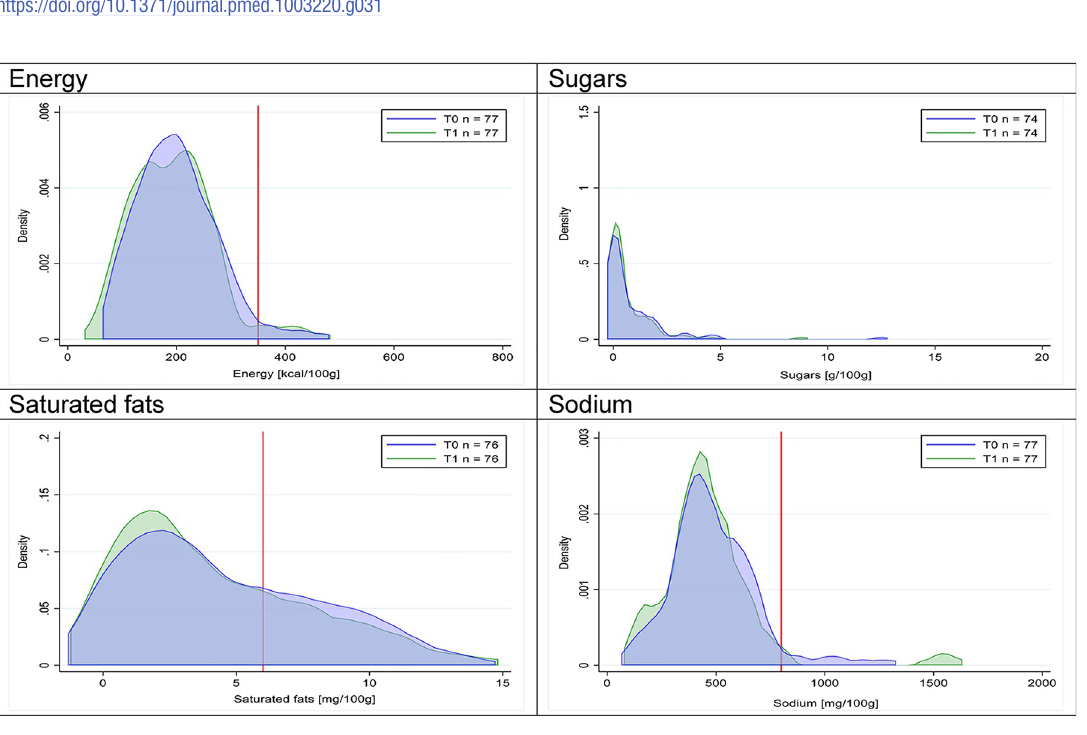
PLOS Medicine| https://doi.org/10.1371/journal.pmed.1003220 July 28,